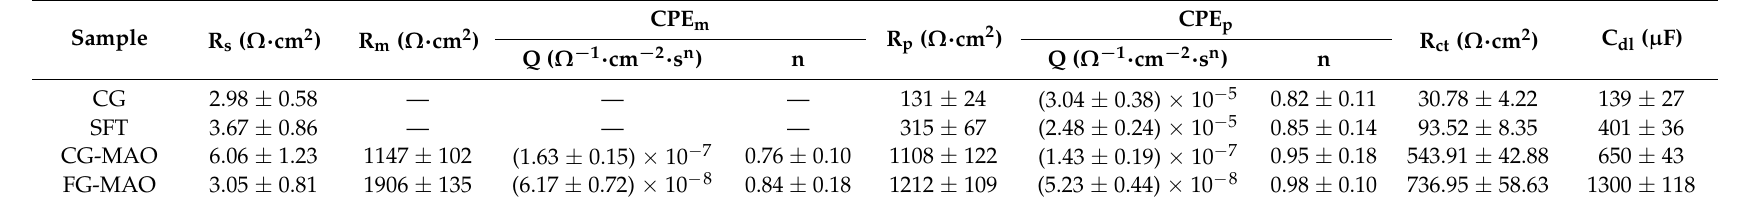
Table 4. Fitting parameters for Nyquist plot of the samples in SBF